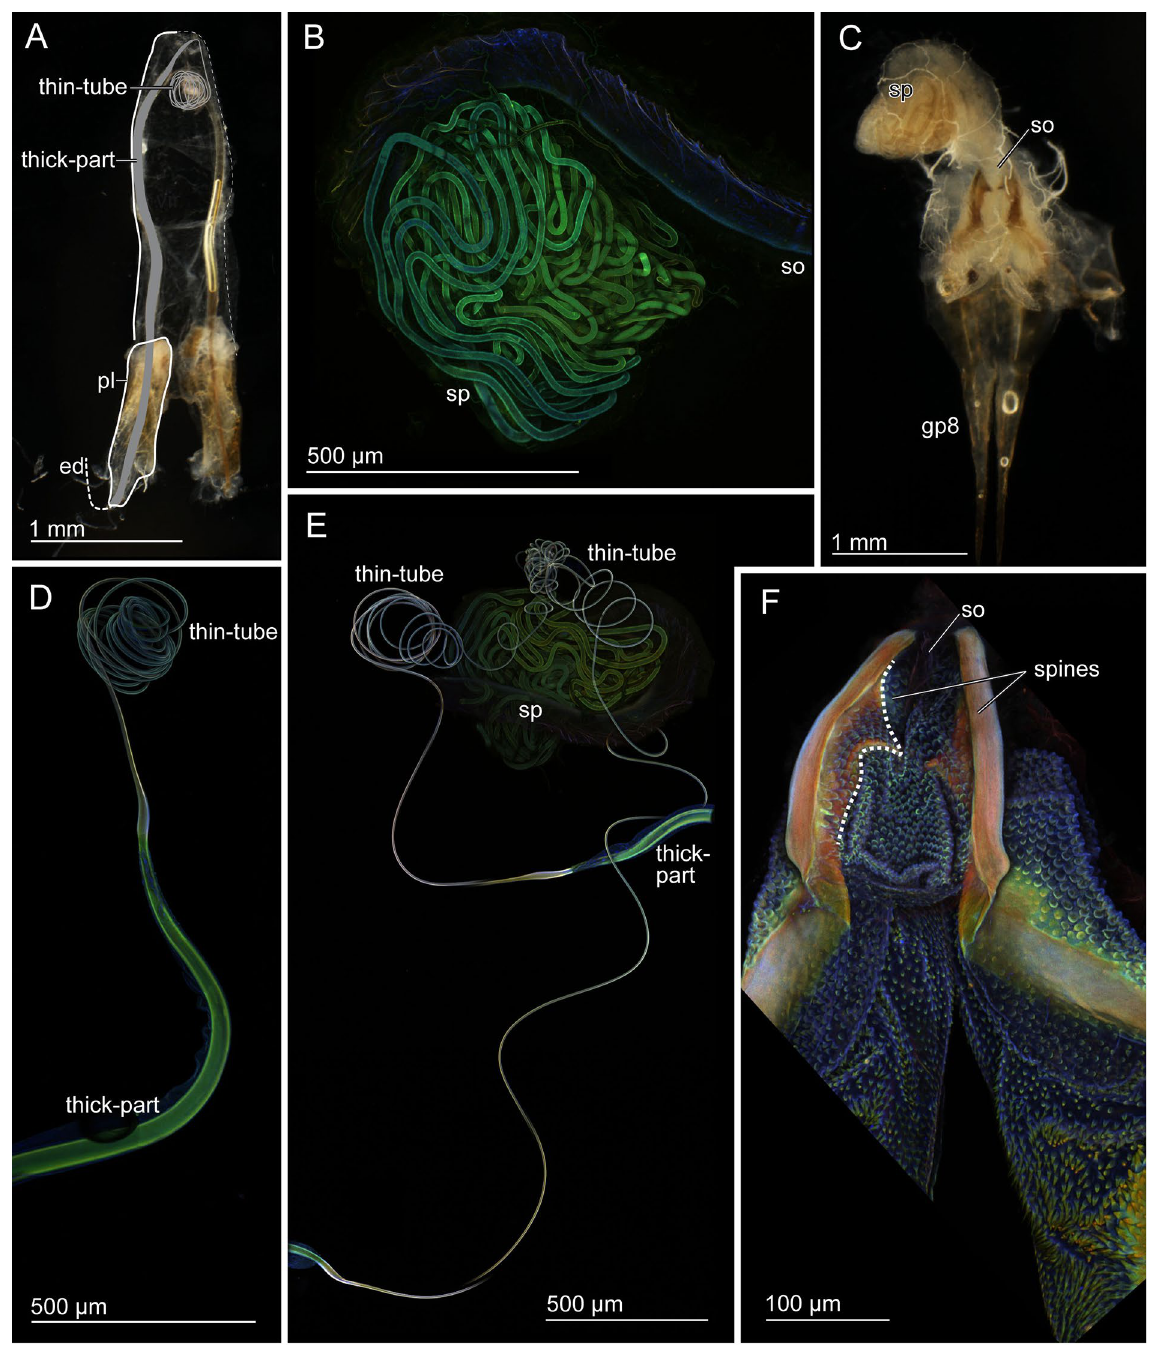
Figure 2. Male and female genitalia of Echinosoma horridum . ( A , C ) Stereomicrographs, ( B , D – F ) confocal laser scanning micrographs. ( A ) Male genitalia. Paired virgae are situated in the genitalia chamber and directed cranially in repose. Half of the paired structures is highlighted. ( B ) Spermatheca. ( C ) Female genitalia. ( D ) Virga. ( E ) Virgae and spermatheca. ( F ) A pair of spines in the vicinity of a spermatheca opening. Abbreviations: ed, ejaculatory duct; gp8, gonapophysis VIII; pl, penis lobe; so, spermatheca opening; sp, spermatheca; vir-thick, thick-part of virga; vir-thin, thin-tube of